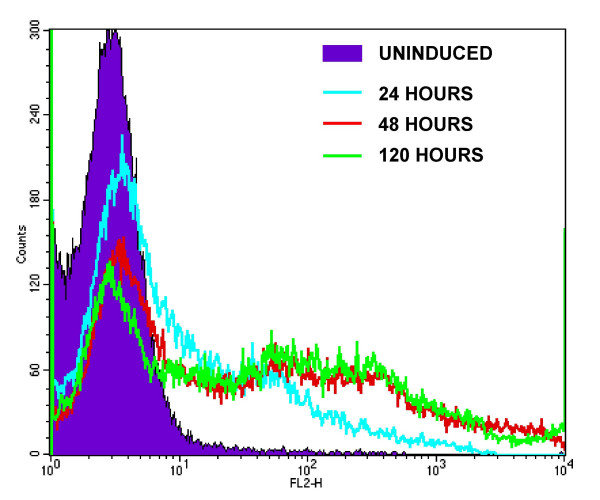
FACS analysis of expression of RFP in a cloned cell line. Tetracycline (0.5 μg ml-1) was added and samples were removed at specific timepoints. The level of fluorescence in the population was measured by counting 5 × 103 cells per timepoint on a FACScan. The filled curve is the uninduced population. The traces for induced cells are shown as overlaid lines: blue, 24 hours: red, 48 hours and green, 120 hours post-induction. The Y axis indicates the number of cells counted, whilst the X axis shows the level of RFP expression in AFU.